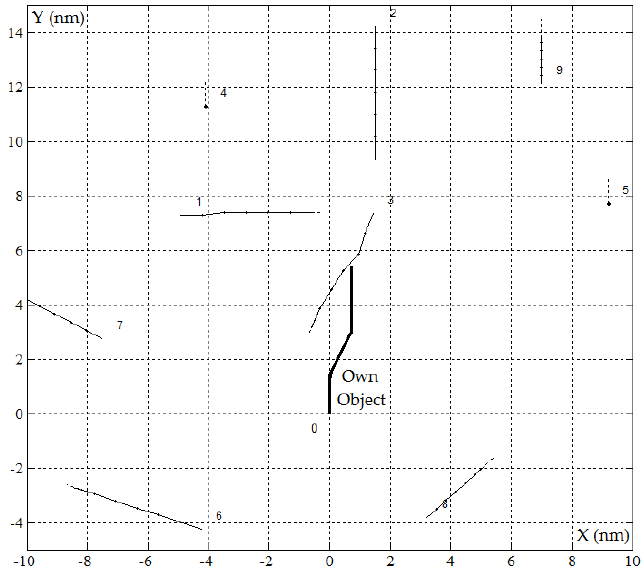
Figure 5. The safe trajectory of the own object for the positional game PG_gv algorithm in good visibility at sea where D s = 0.5 nm in the situation of passing J = 9 encountered objects, r ( tK ) = 0 and d ( tK ) = 0.71 nm.